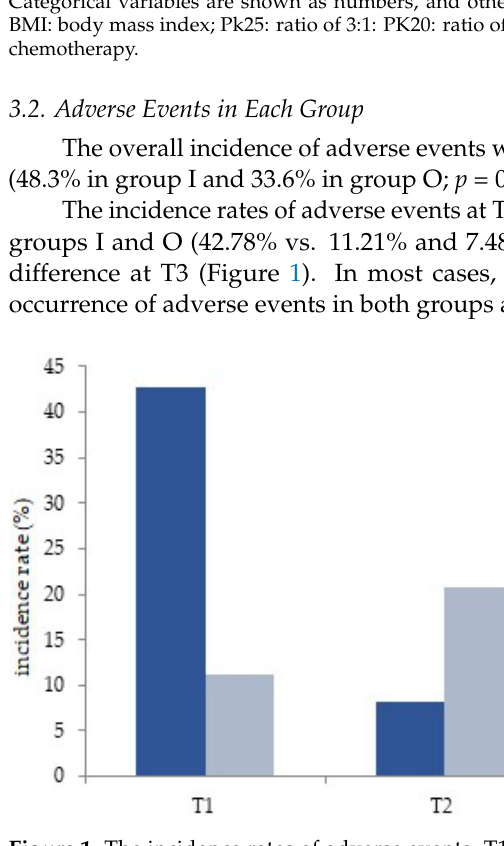
Figure 1. The incidence rates of adverse events. T1: acute period (<2 h); T2: early period (<12 h); T3: late period (<24 h).